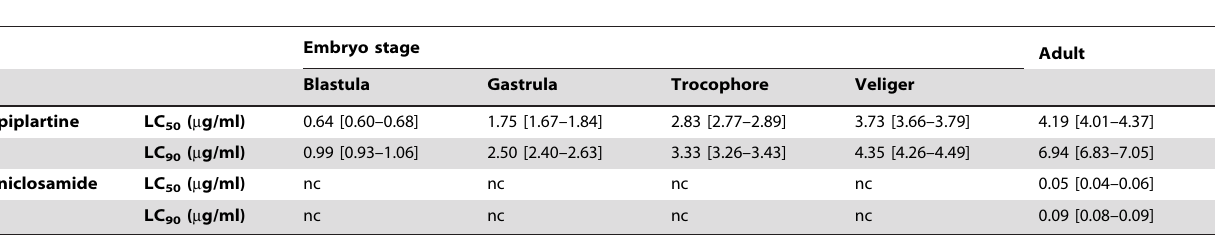
Table 3. LC 50 and LC 90 for B. glabrata embryos and adults exposed to